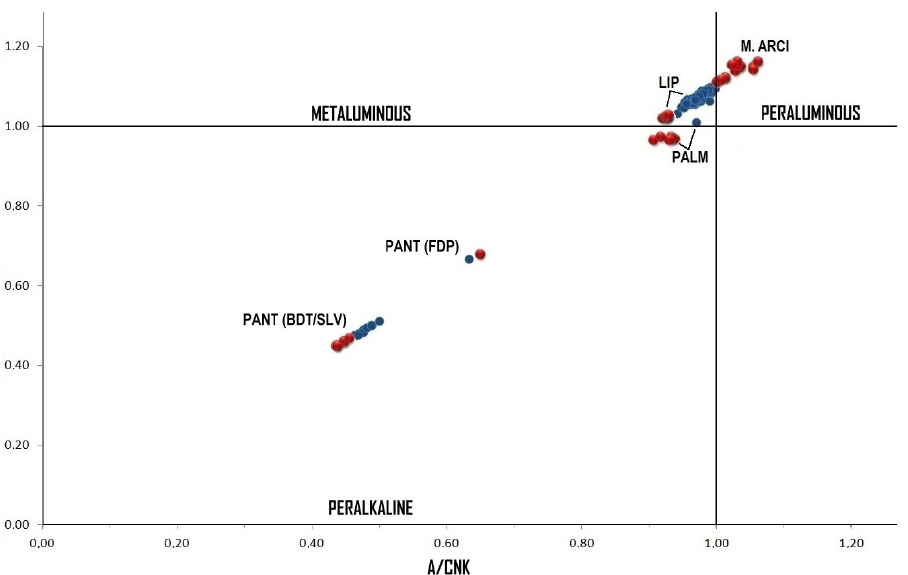
O /(CaO+Na O+K O)] vs A/NK [molar ratio Al 2 3 2 2